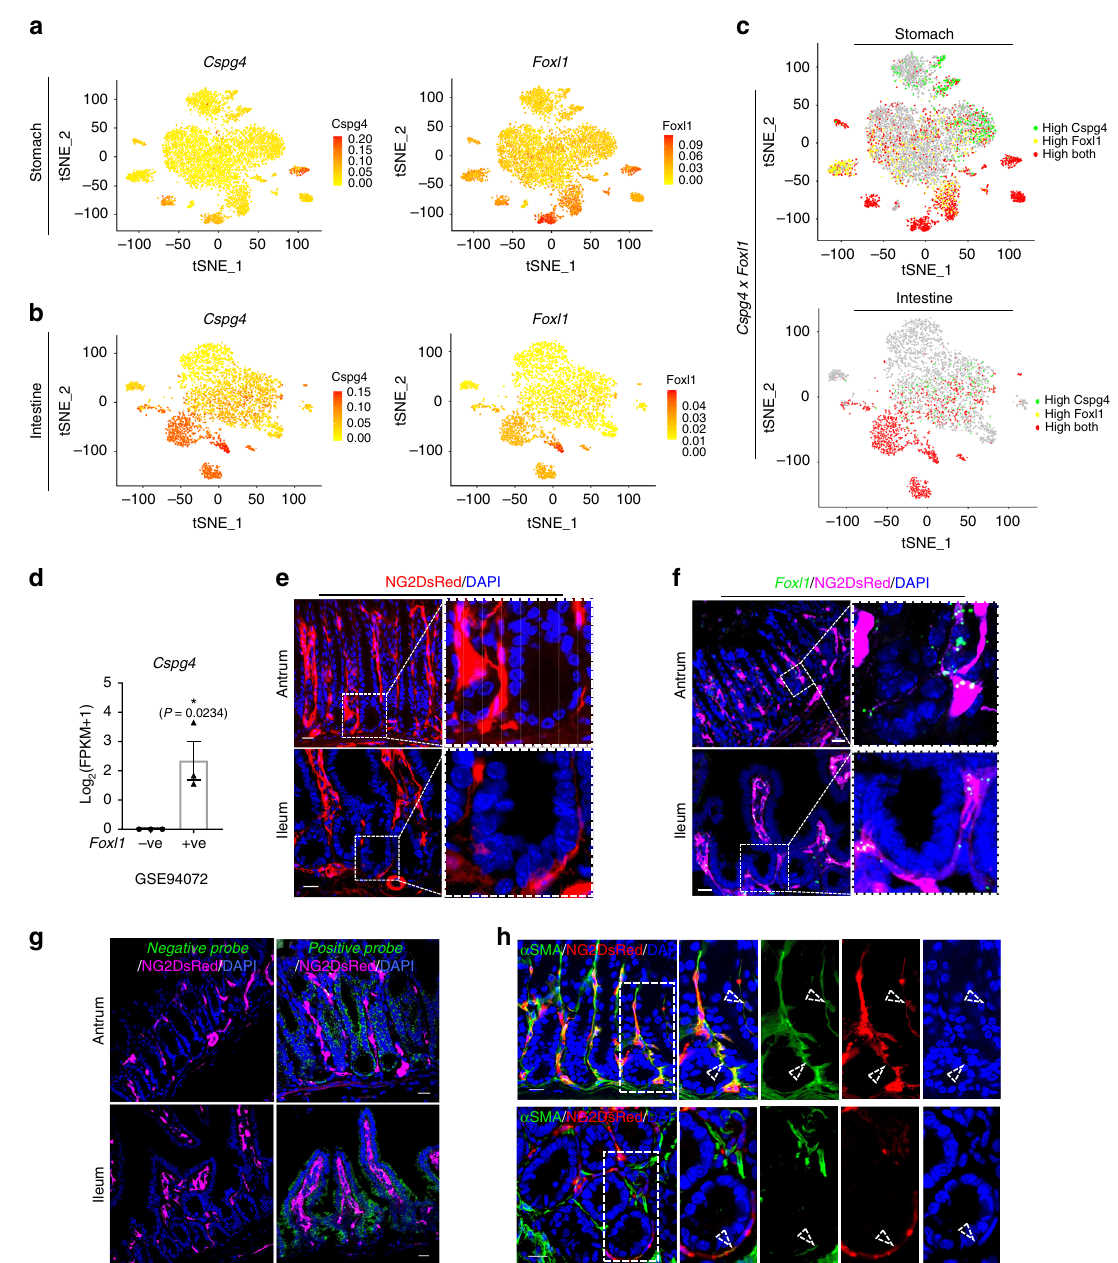
Fig. 2 Co-expression of pericyte and telocyte markers by conserved stromal cells. a , b Feature plot (FP) of Cspg4 ( Ng2 ) and Foxl1 in stomach ( a ) and intestine ( b ). c co-FP of Cspg4 and Foxl1 in stomach and intestine t-SNE plot. Red dots mean cells expressing both genes. d Comparison of Cspg4 expression levels between Foxl1 -positive and -negative cells from the GSE94072 dataset shows highly enriched expression of Cspg4 in Foxl1 -positive cells. n = 3, biologically independent samples. * P < 0.05 by unpaired student t test. Values are mean ± SEM. e Real-time Ng2 expression in antral glands and intestinal crypts of Ng2 + /DsRed mice shows pericyte-like stromal cells in proximity to stomach and intestinal epithelial cells. Scale bars indicate 20 μ m. f Single- molecule FISH (smFISH) of Foxl1 (green puncta) in Ng2 + /DsRed (magenta) mice. Scale bars indicate 20 μ m. Area in dotted squares in left are magni fi ed to right dotted square. g Images of negative (left) control with a probe targeting the DapB gene (accession # EF191515) from the Bacillus subtilis strain SMY, a soil bacterium, and of positive (right) control with probes targeting Polr2a (green) and Ppib (blue) in the antrum (upper panel) and ileum (lower panel) related to Fig. 2f. Scale bars indicate 20 μ m. h IF staining of α SMA in Ng2 + /DsRed mice. Empty arrowhead indicates co-expressing cells; fi lled arrowhead indicates only DsRed positive cells; arrow indicates green color single positive cells. Sub-population of α SMA expressing cells are co-labeled with DsRed. Scale bars indicate 20 μ m. Blue is